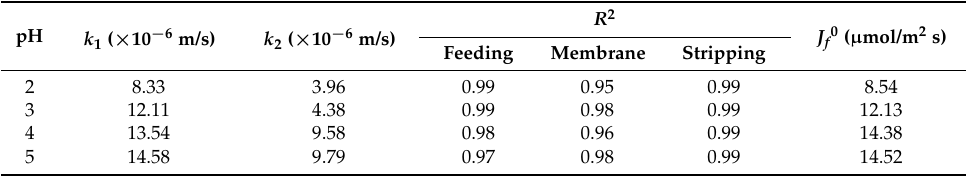
Table 2. The fitted apparent rate constant and initial flux in the feeding phase.